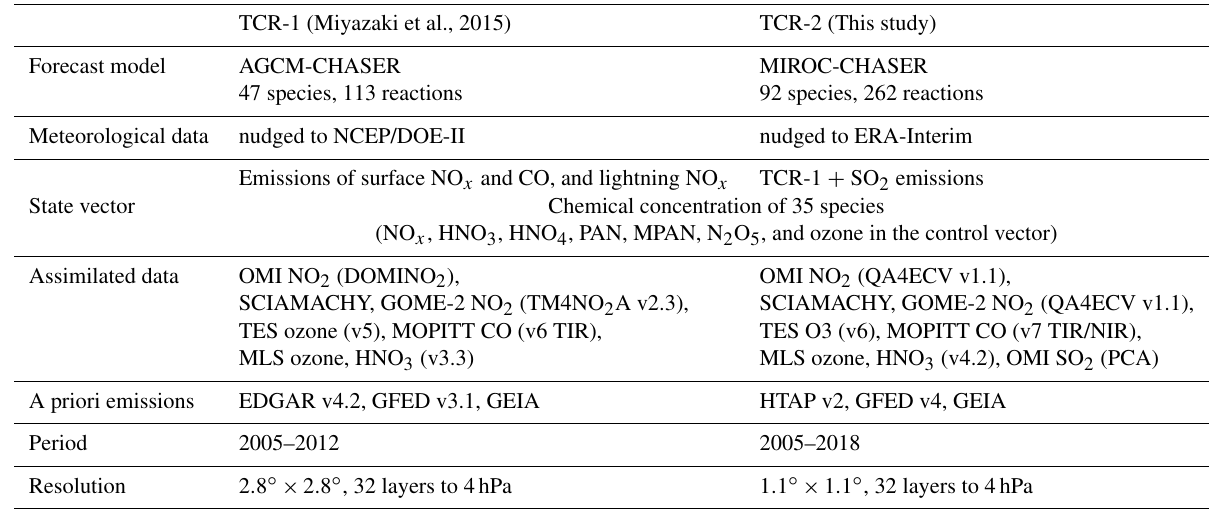
Table 1. Comparisons of TCR-1 and TCR-2. TCR-1 (Miyazaki et al., 2015) TCR-2 (This